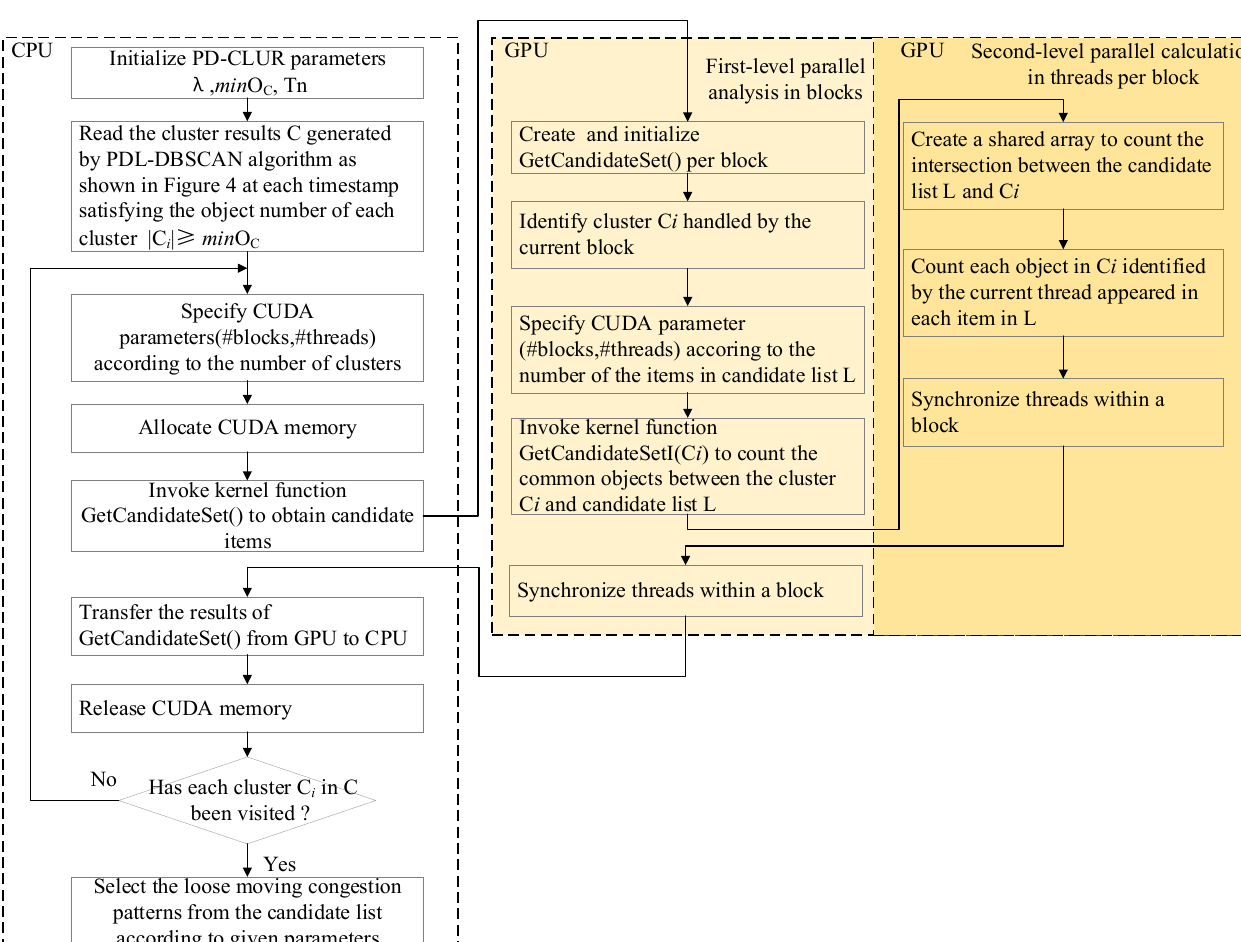
Figure 2. The flow chart of PDCLUR algorithm.